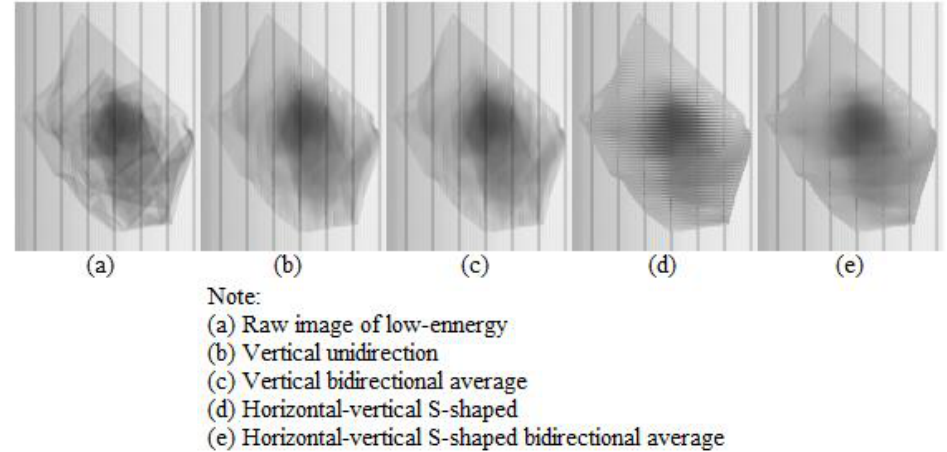
Figure 7. Comparison of filtering effects of different calculation scanning modes for low-energy image of the sample material (Figure 1 shows local enlarged image of low-energy image after processing).